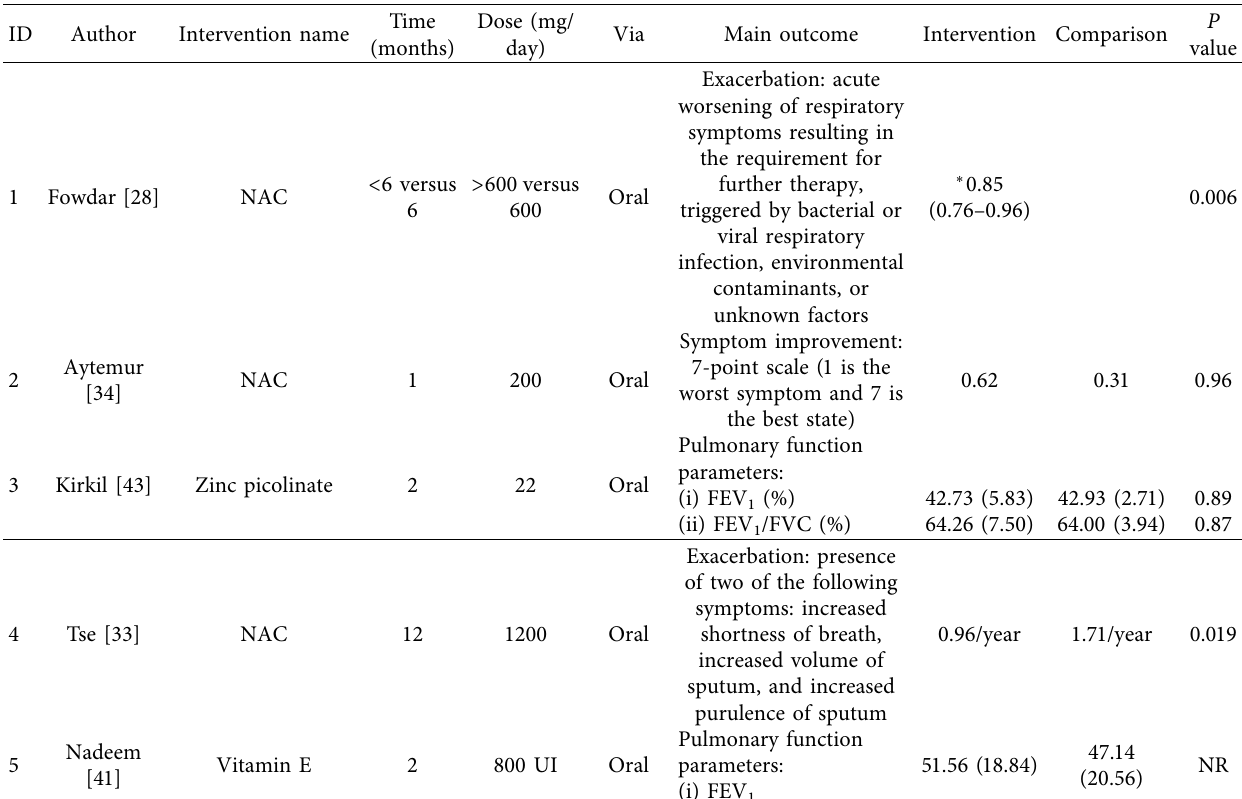
Table 2: Type of intervention and primary outcomes